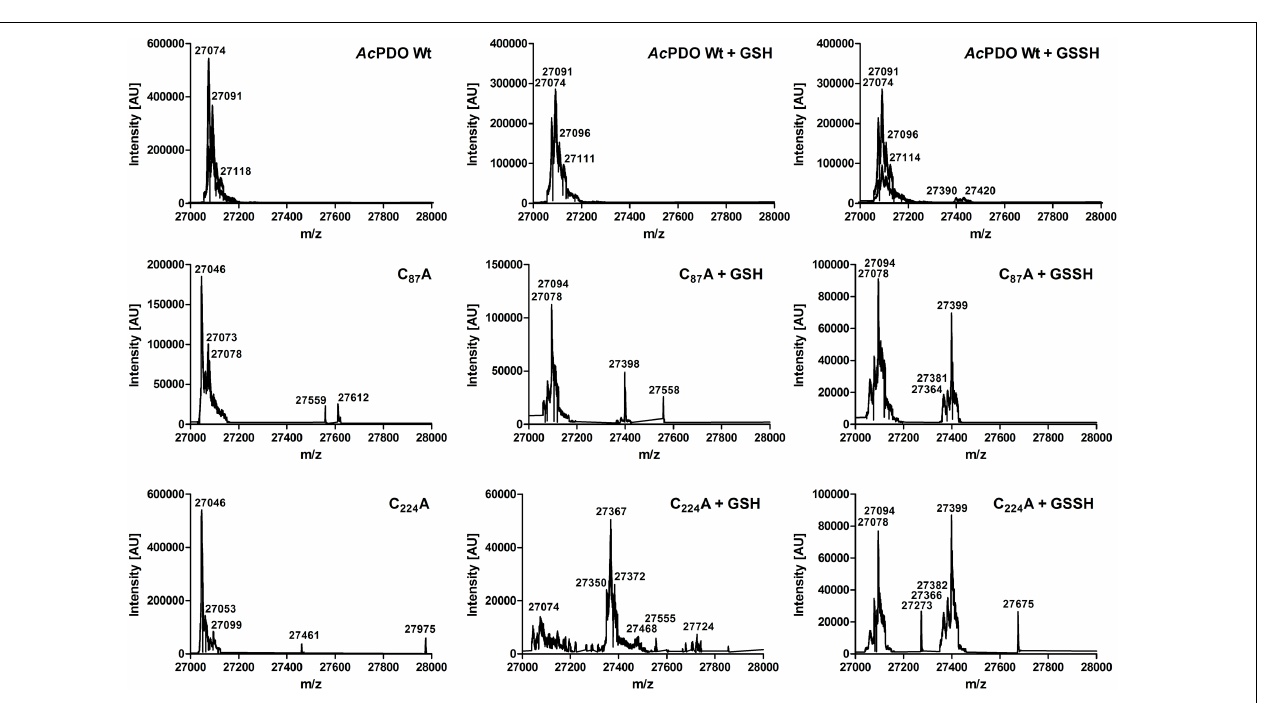
( + 16; Figure 8 and Supplementary Figure S7). A broad